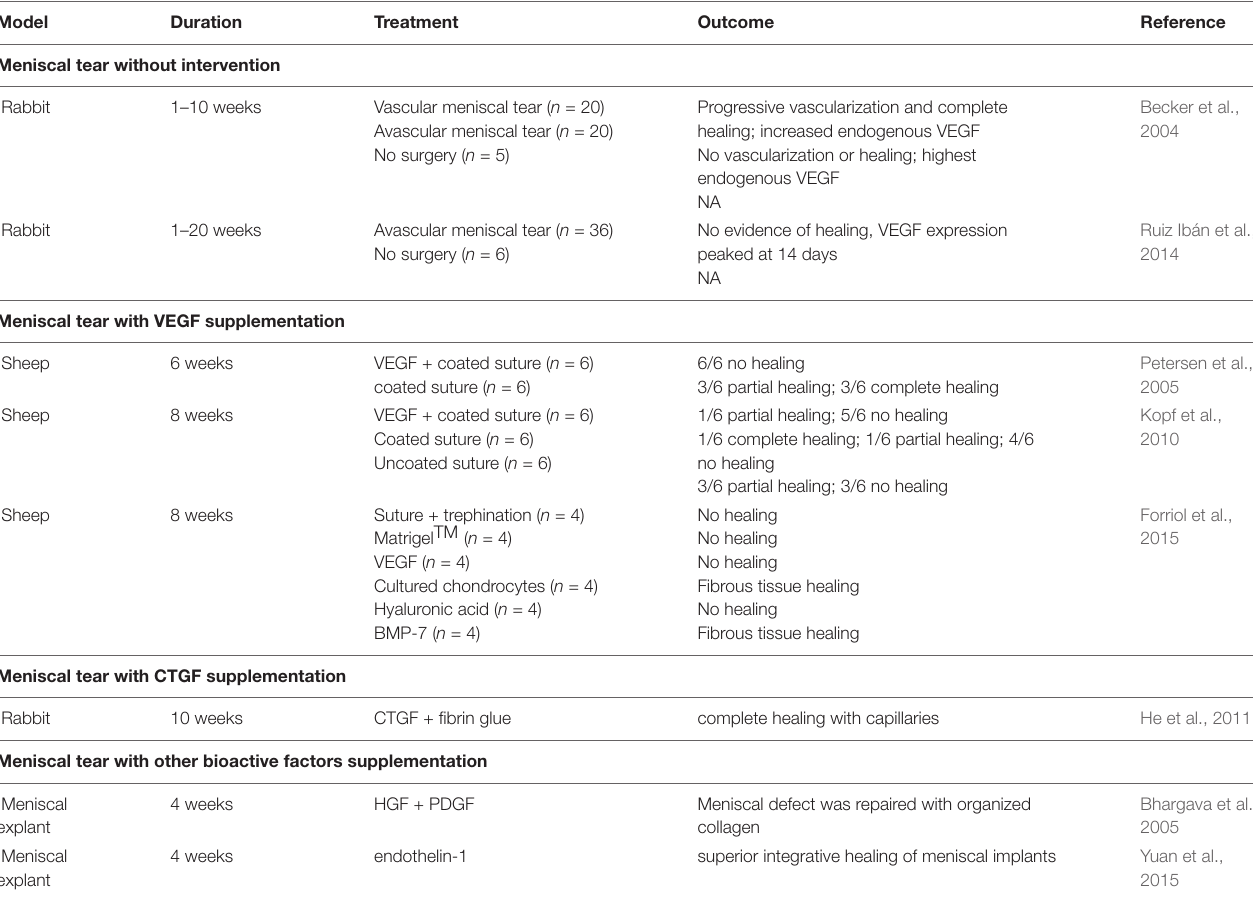
TABLE 4 | Summary of studies regarding promoting vascularization in the healing of avascular meniscal lesions.